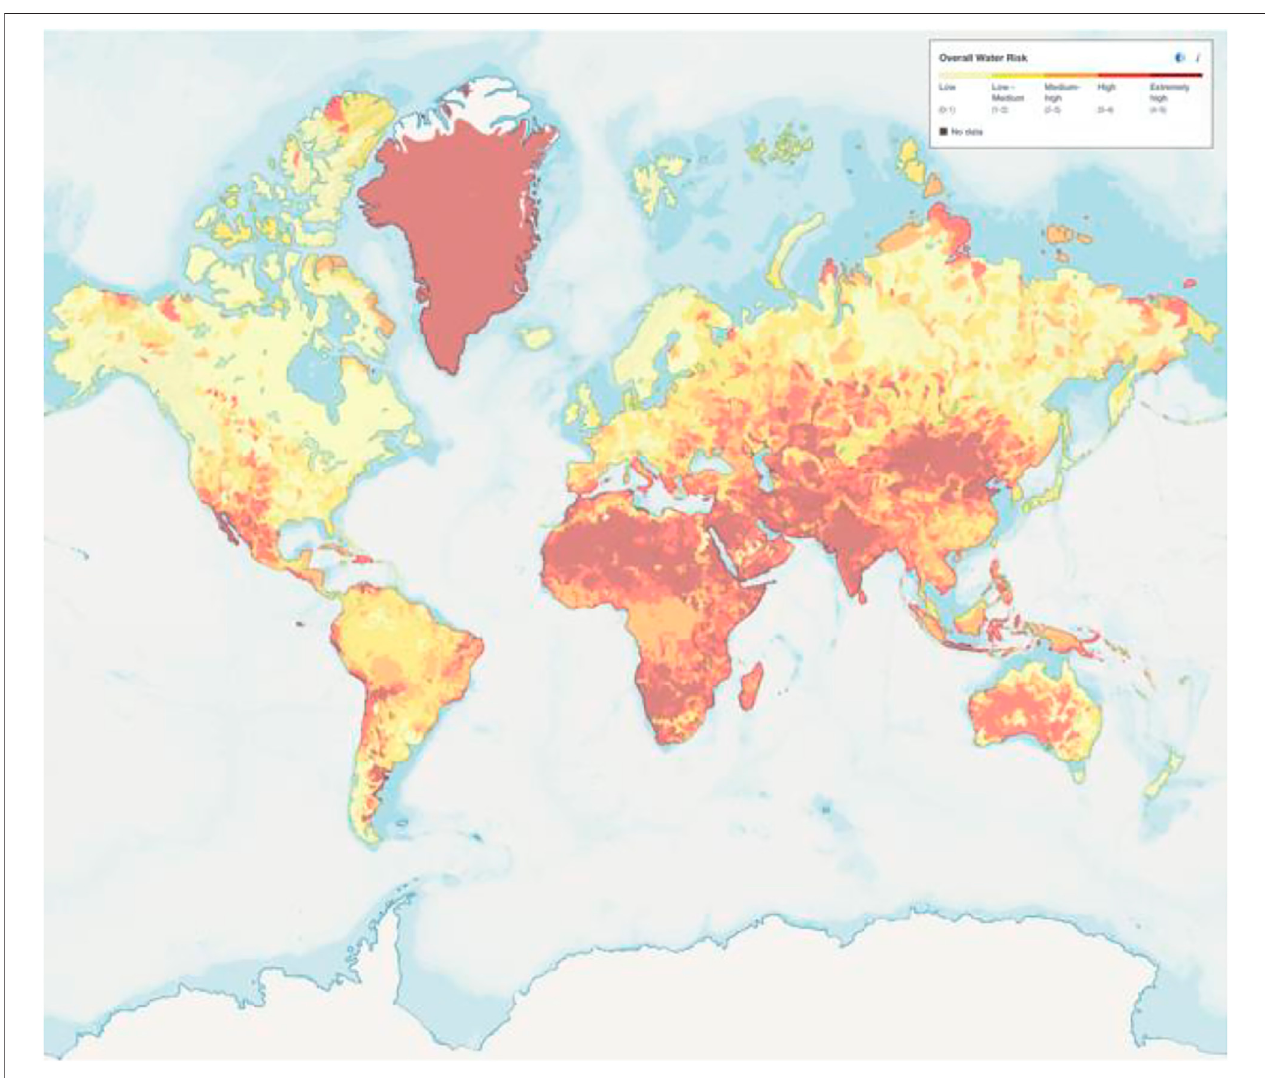
FIGURE 10 | Global drought risk and water stress (https://wri.org/applications/aqueduct/water-risk-atlas/#/ ?advanced (cid:1) false&basemap (cid:1) hydro&indicator (cid:1) w_awr_def_tot_cat&lat (cid:1) -8.841651120809145&lng (cid:1) 35.06835937500001&mapMode (cid:1) view&month (cid:1) 1&opacity (cid:1) 0. 5&ponderation (cid:1) DEF&prede fi ned (cid:1) false&projection (cid:1) absolute&scenario (cid:1) optimistic&scope (cid:1) baseline&timeScale (cid:1) annual&year (cid:1) baseline&zoom (cid:1) 3). Used by